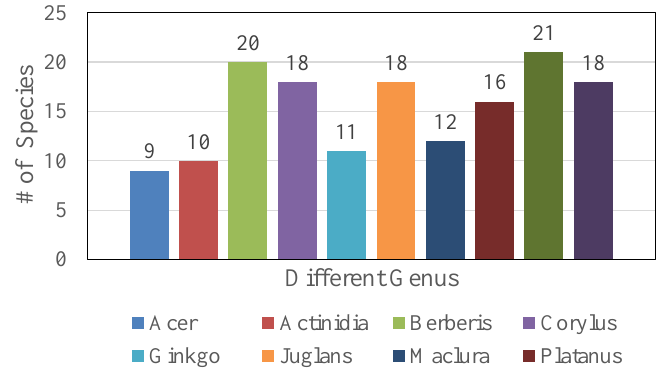
Figure 8. The species number for the 10 genera of the MEW2012